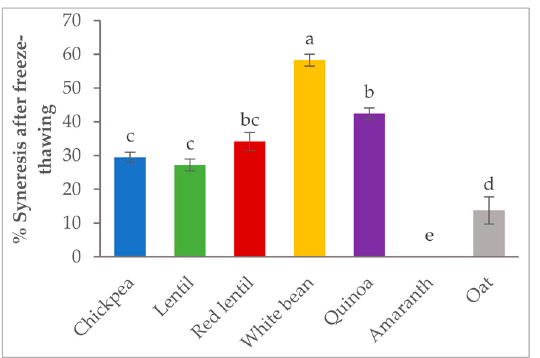
Figure 4. Percentages of syneresis after freeze-thawing of flour pastes. Values not sharing letters are significantly different according to Fisher’s LSD test ( p <